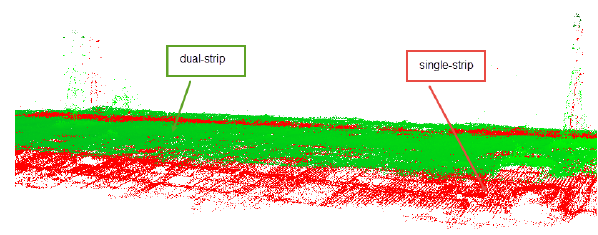
Figure 8. Overlap display of 3D point cloud of tie-points from single-strip and